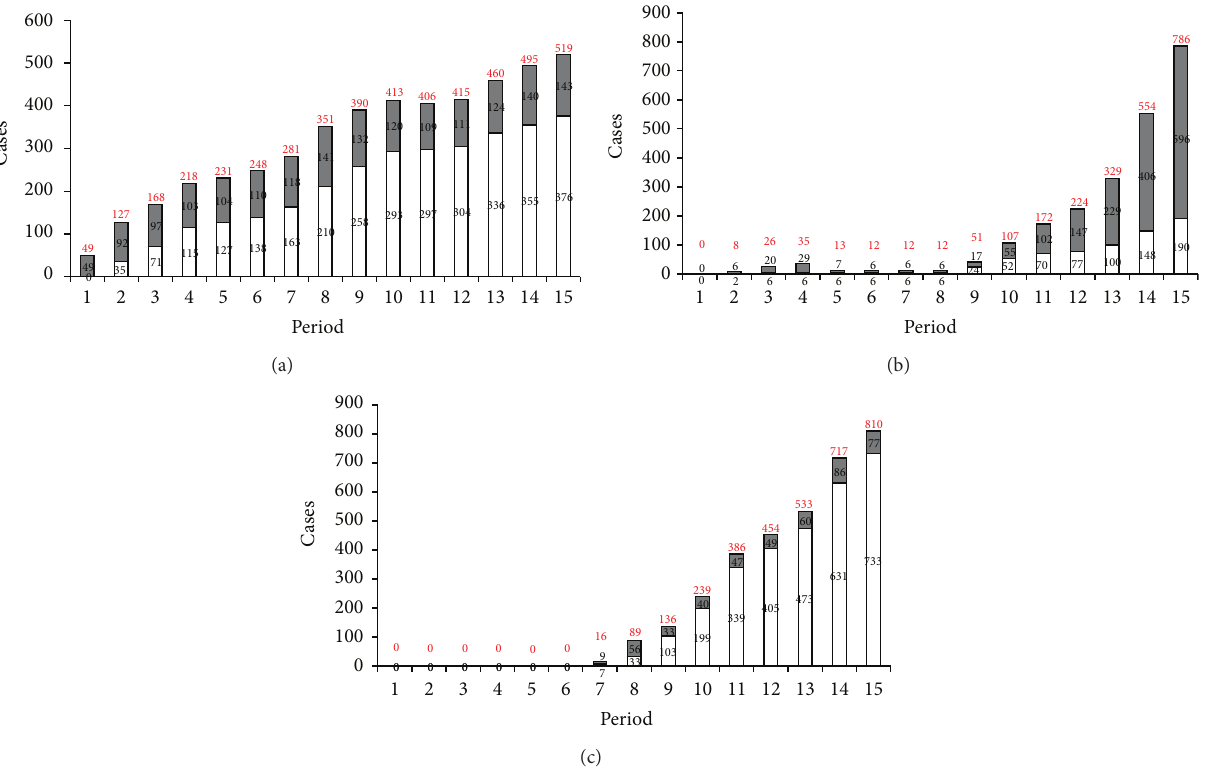
Figure 2: Time trend of compatible EVD cases (confirmed, white bars; probable and suspected, grey bars) in affected countries Guinea (a), Liberia (b), and Sierra Leone (c) according to the periods reported in Table 1. Red numbers over each bar represent the total amount of all compatible cases (confirmed, probable, and suspected) for each